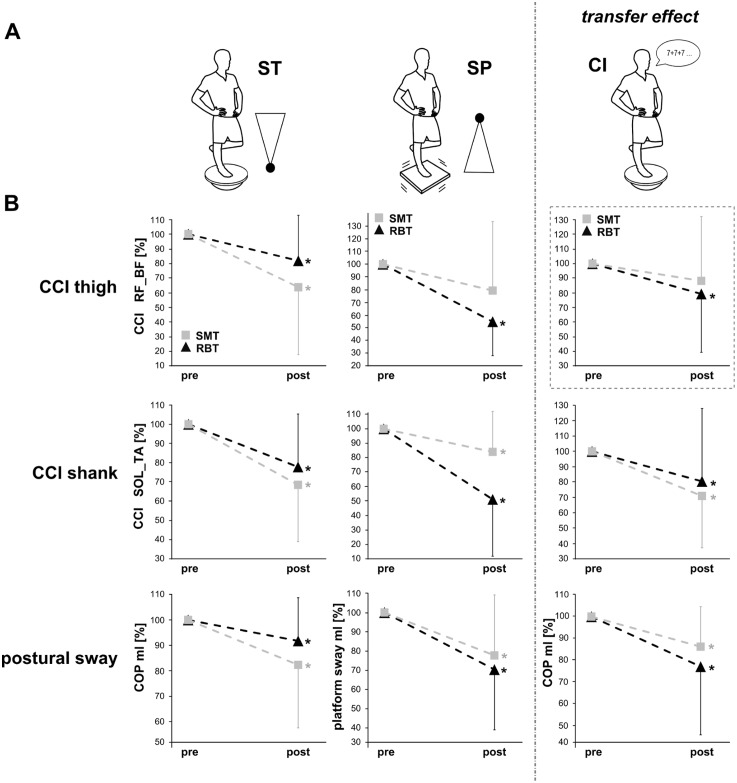
Changes in neuromuscular activation and postural sway in response to both interventions.(B) Changes in thigh (upper row) and shank (middle row) CCIs as well as COPml/postural sway (bottom row) in response to the training interventions SMT (grey square) and RBT (black triangle) in (A) the three different test paradigms on the spinning top (ST, left column), on the swinging platform (SP, middle column) and during the transfer condition with cognitive interference (CI, right column). Adaptations in all parameters were greater in the SMT-group than in the RBT-group for ST, whereas during SP, adaptations were greater in the RBT-group than in the SMT-group. For CI, a greater reduction in COPml displacement was observed in the RBT-group: it is assumed that the higher decrease in thigh CCI (dashed box) led to the better functional balance performance.